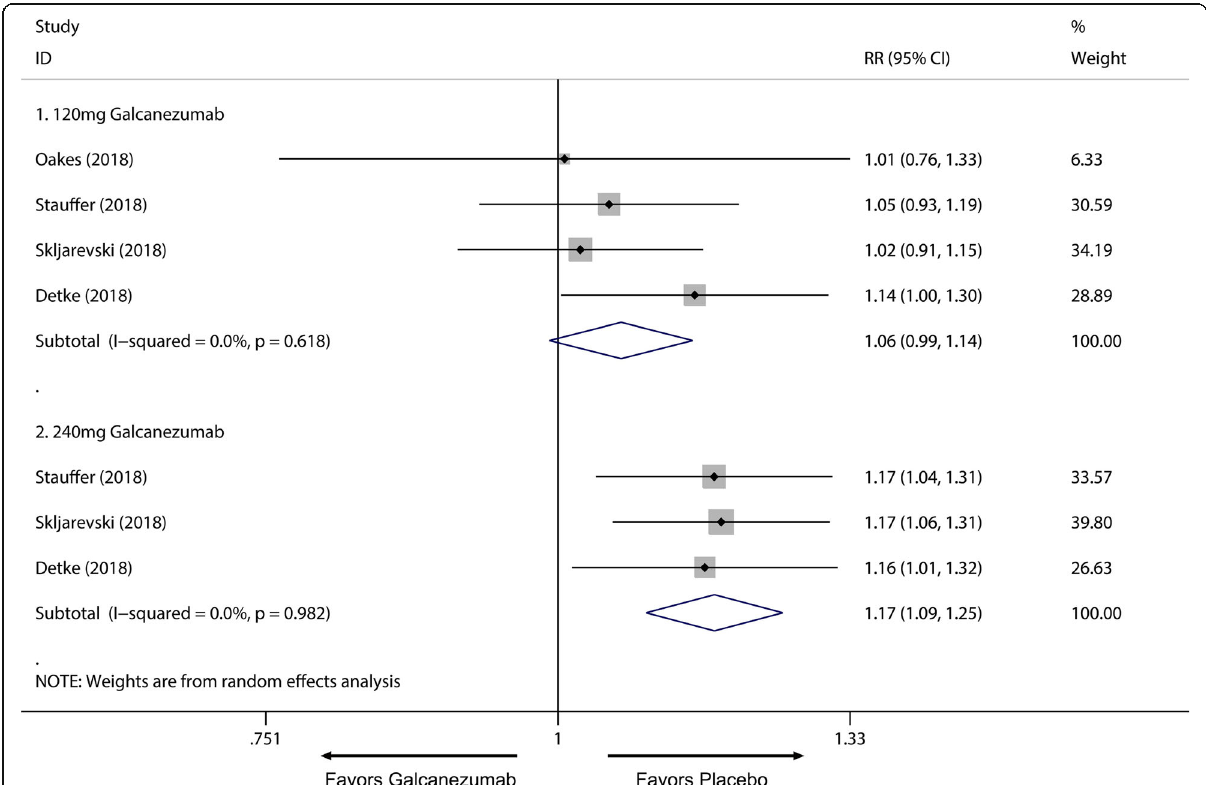
Fig. 7 Pooled TEAEs relative risk in 120 mg and 240 mg galcanezumab group. RR relative